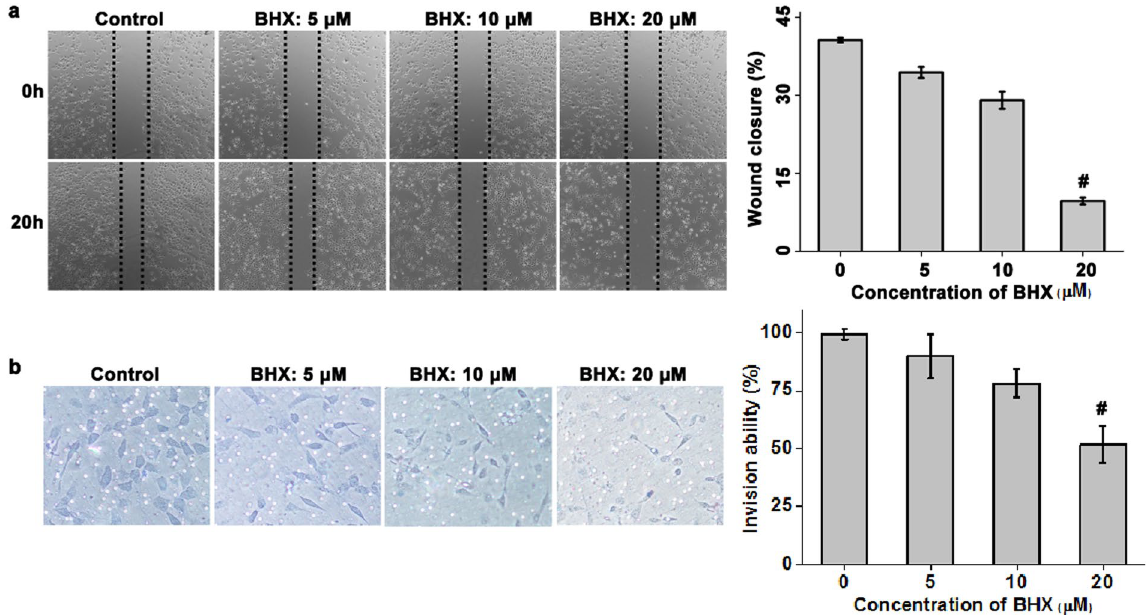
Figure 3. BHX suppresses EMT. Representative images and quantification of wound healing (a) and Transwell migration assay (b) of MDA-MB-231 cells after BHX treatment. Data are expressed as means ± S.D. from three independent experiments. # p <